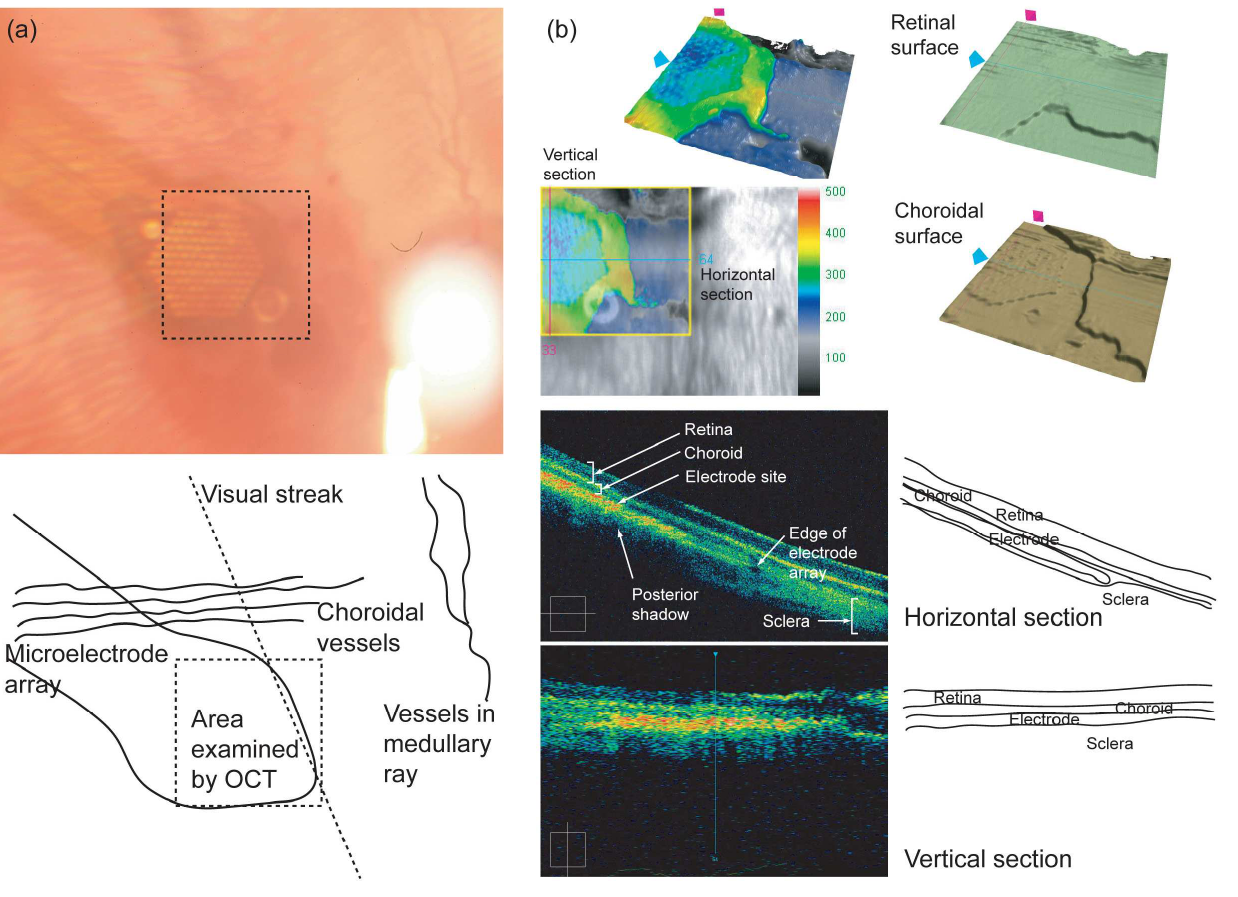
Figure 4. Suprachoroidally implanted microelectrode array in the rabbit eye observed four weeks after implantation. (a) Fundus examination showed that choroidal vessels run over the electrode array and the stimulation site was located near the visual streak. (b) The cross-sectional view (lower half) of the optical coherent tomography revealed that overlying retina and choroids were intact without inflammation or swelling. Indented choroidal surface in the en face view (upper half) reflected the pillar structure of the